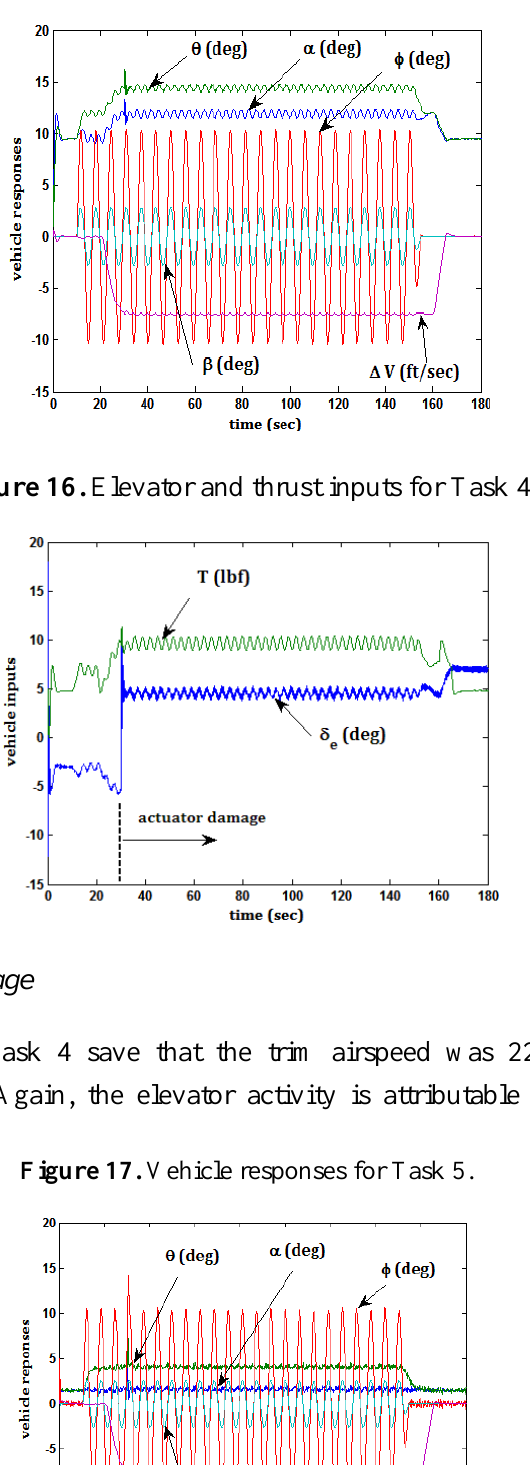
Figure 15. Vehicle responses for Task 4.